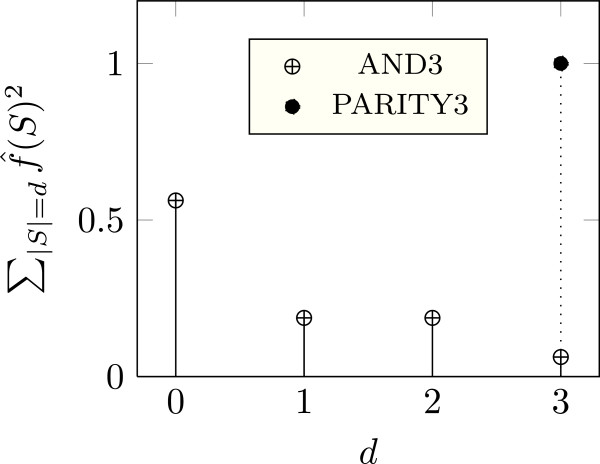
The Fourier spectrum of AND3 and PARITY3.